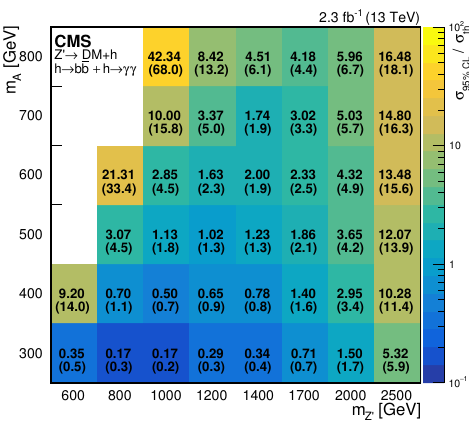
Figure 11 . The observed (expected) 95% CL limits on the signal strength (as in (cid:12)gure 9 right) for the combination of h ! (cid:13)(cid:13) and h ! bb decay channels, and for m A = 300{800 GeV and m Z 0 = 600{2500 GeV. Other parameters for this model are (cid:12)xed to m (cid:31) = 100 GeV and tan (cid:12) = g (cid:31) = 1. The theoretical cross sections times branching fractions are calculated using g Z 0 = 0 :